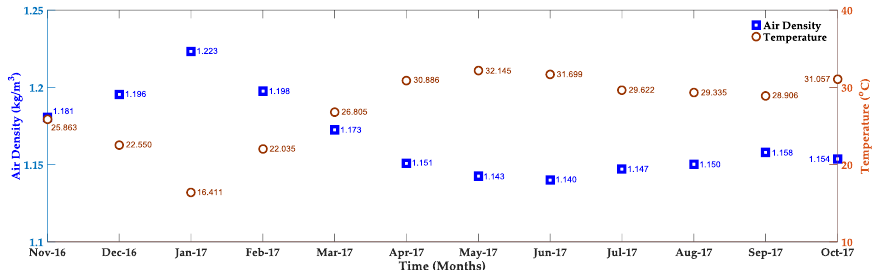
Figure 8. Relation between monthly averages of air density and temperature for at Sanghar site.